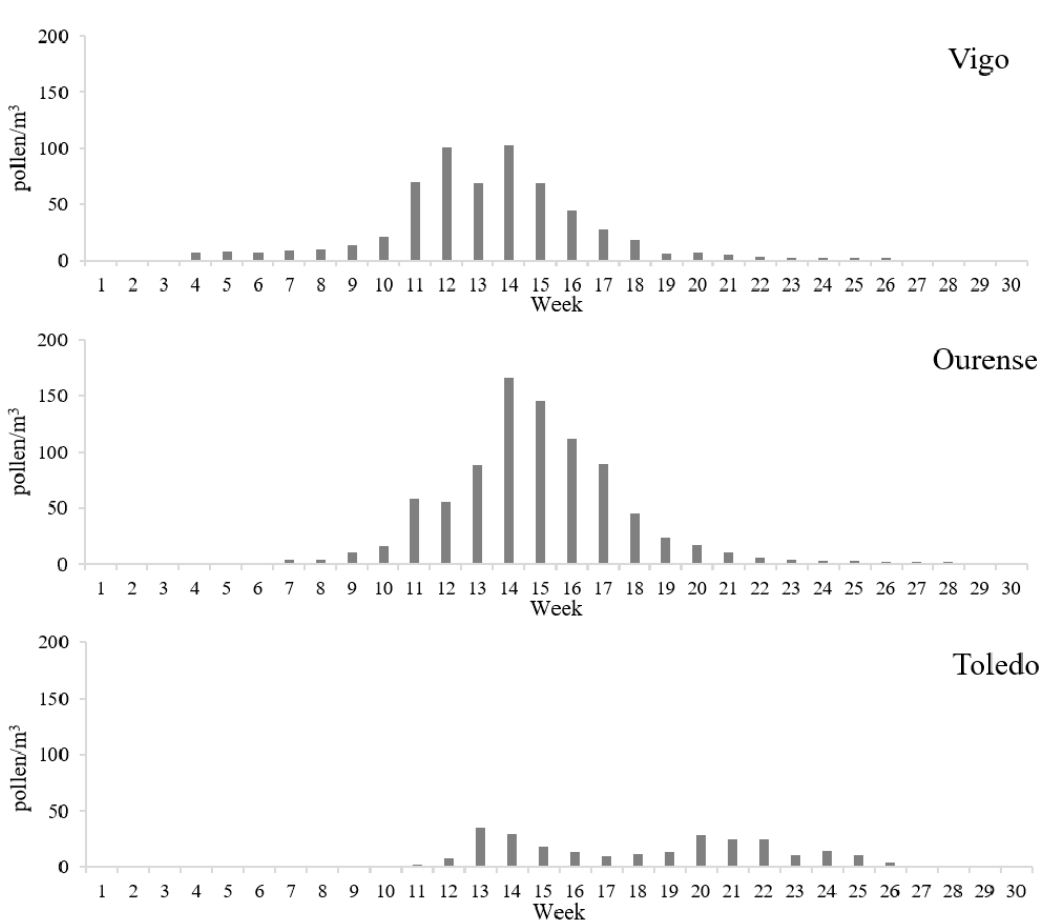
Figure 2. Weekly distribution of Pine pollen during the study years in each area studied (Eurosiberian, Vigo; transition, Ourense; and Mediterranean, Toledo).